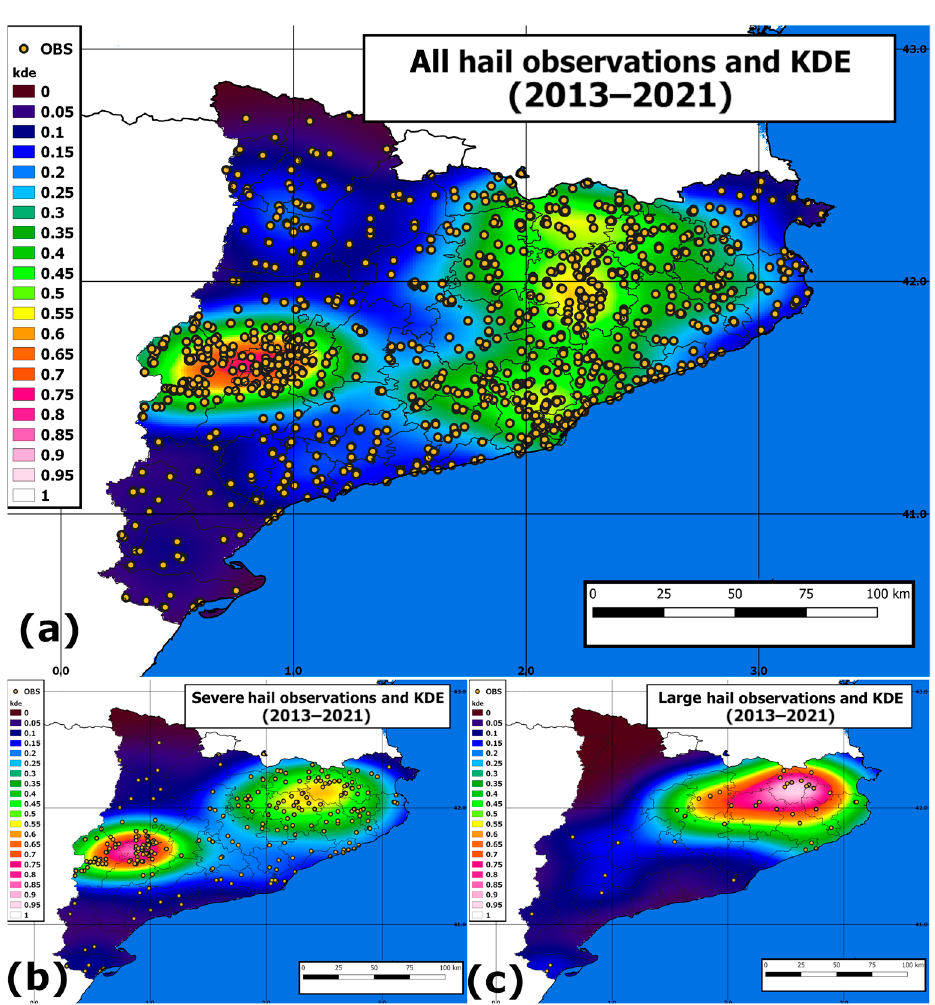
Figure 6. ( a ): Kernel Density Estimator field for the hail occurrence (any size) for the period 2013–2021. ( b ): the same for the severe hail registers ( ≥ 2 cm size). ( c ): equal, but for the large hail registers ( ≥ 4 cm).